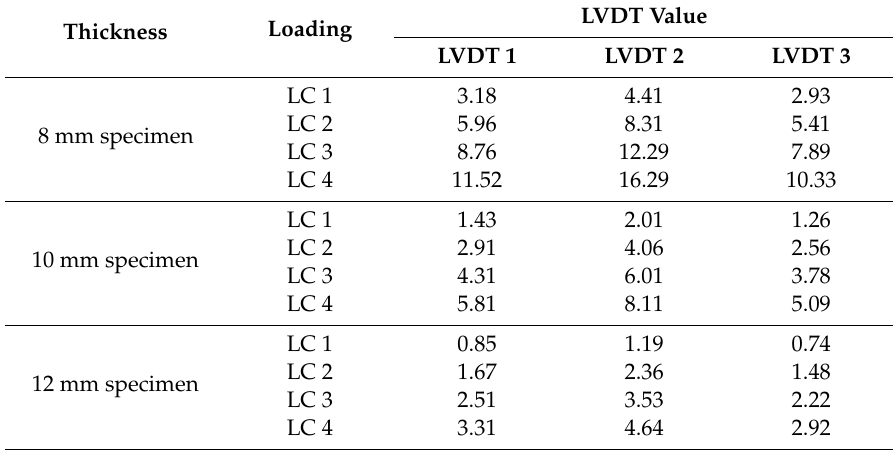
Table 4. LVDT measurement results for three